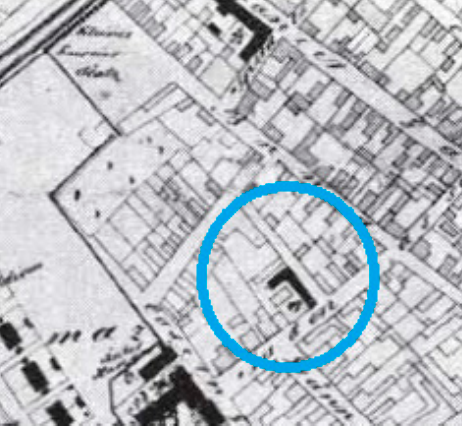
Figure 2. Carl Berthold’s plan of the City of Zemun with Jewish street, 1830.